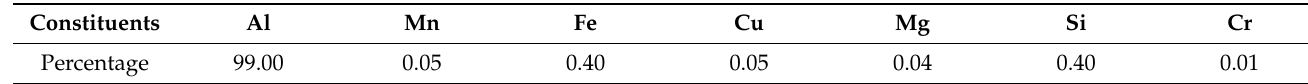
Table 2. Elemental analysis of Al 1100.